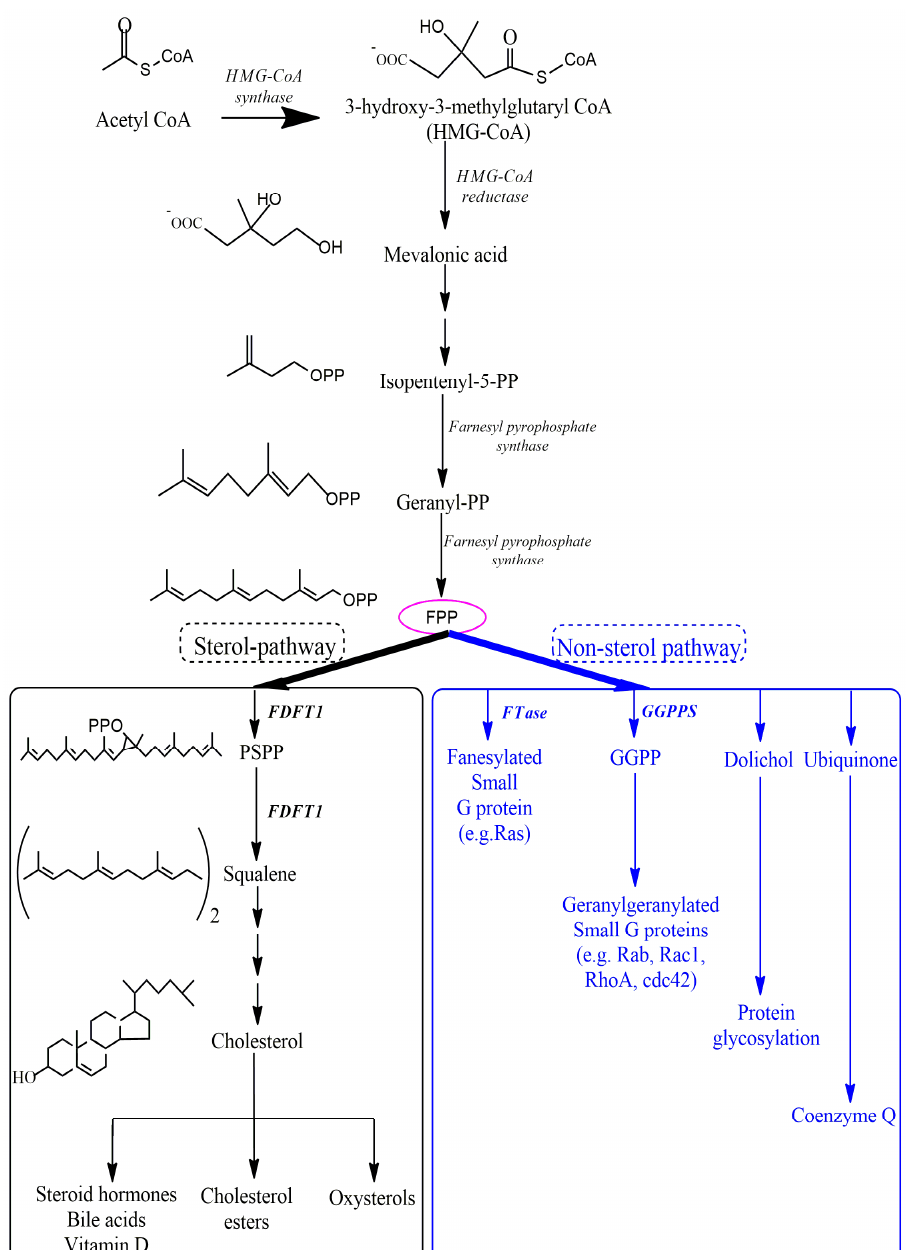
Figure 1. Biosynthesis of cholesterol and its derivatives. Squalene synthase (FDFT1) is the critical enzyme for the synthesis of sterols, and ultimately cholesterol. This enzyme plays an essential role in directing intermediates to either sterol or nonsterol branches of this metabolic pathway [60,61]. SREBPs bind to SRE-like sequences located within 198–127 base pairs (bp) of the transcription start site of the FDFT1 gene. However, SREBPs are only weak transcriptional activators by themselves. The binding of one or more additional transcription factors, such as members of the SP1